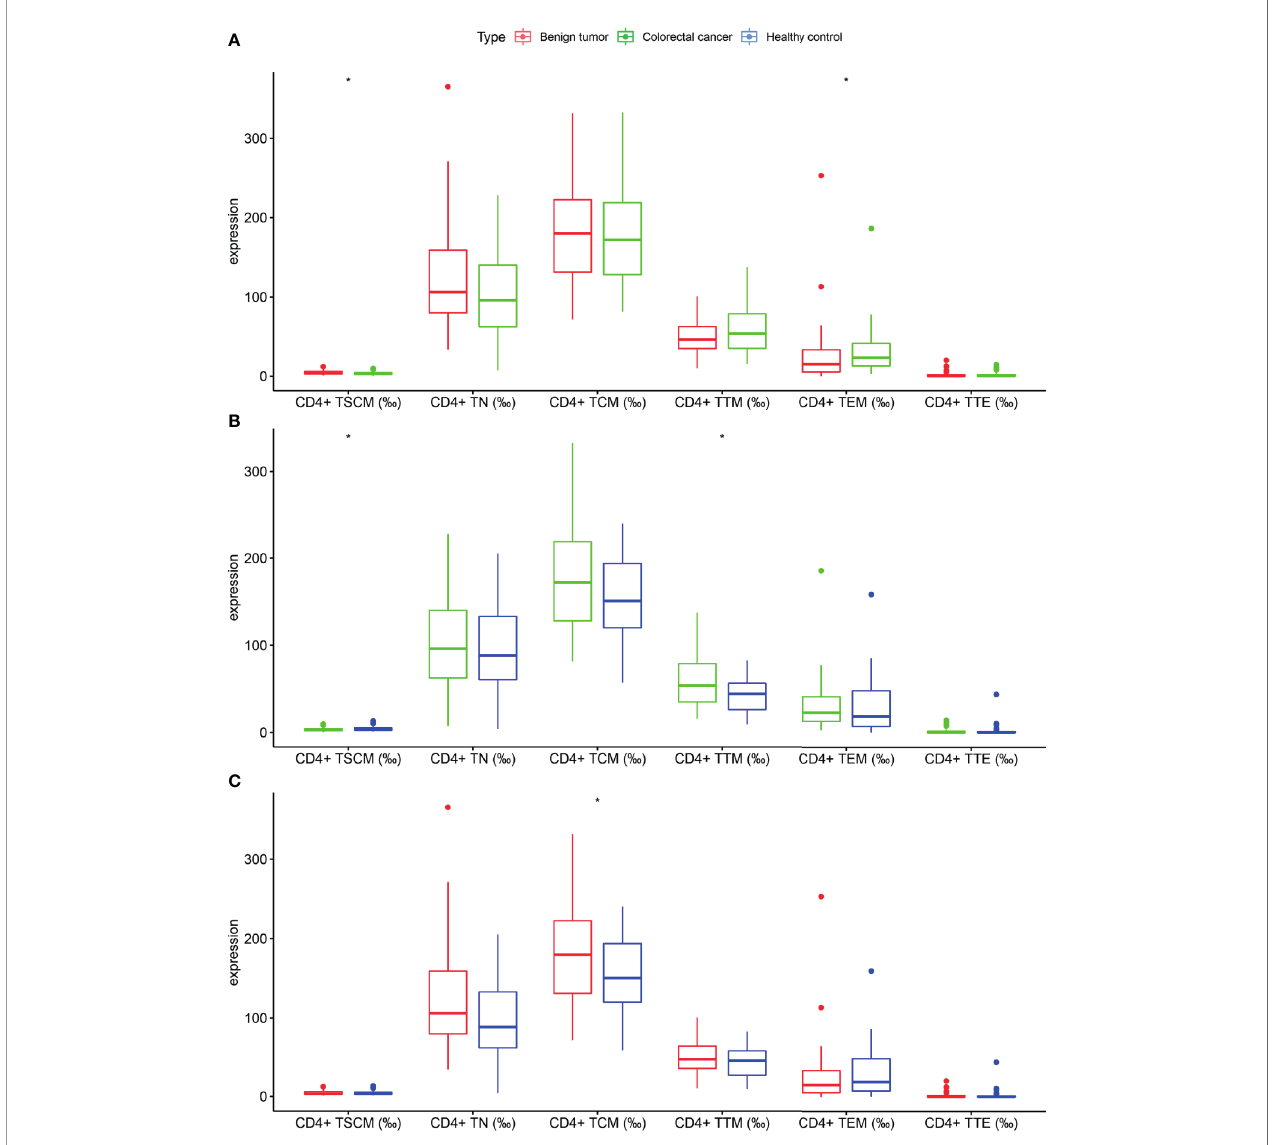
FIGURE 3 | Differences in the frequency of CD4 + lymphocyte subsets in subjects in the colorectal cancer, benign tumor, and healthy control groups (A) Colorectal cancer group vs . benign tumor group; (B) Colorectal cancer group vs . healthy control group; (C) Benign tumor group vs . healthy control group. * p < 0.05.